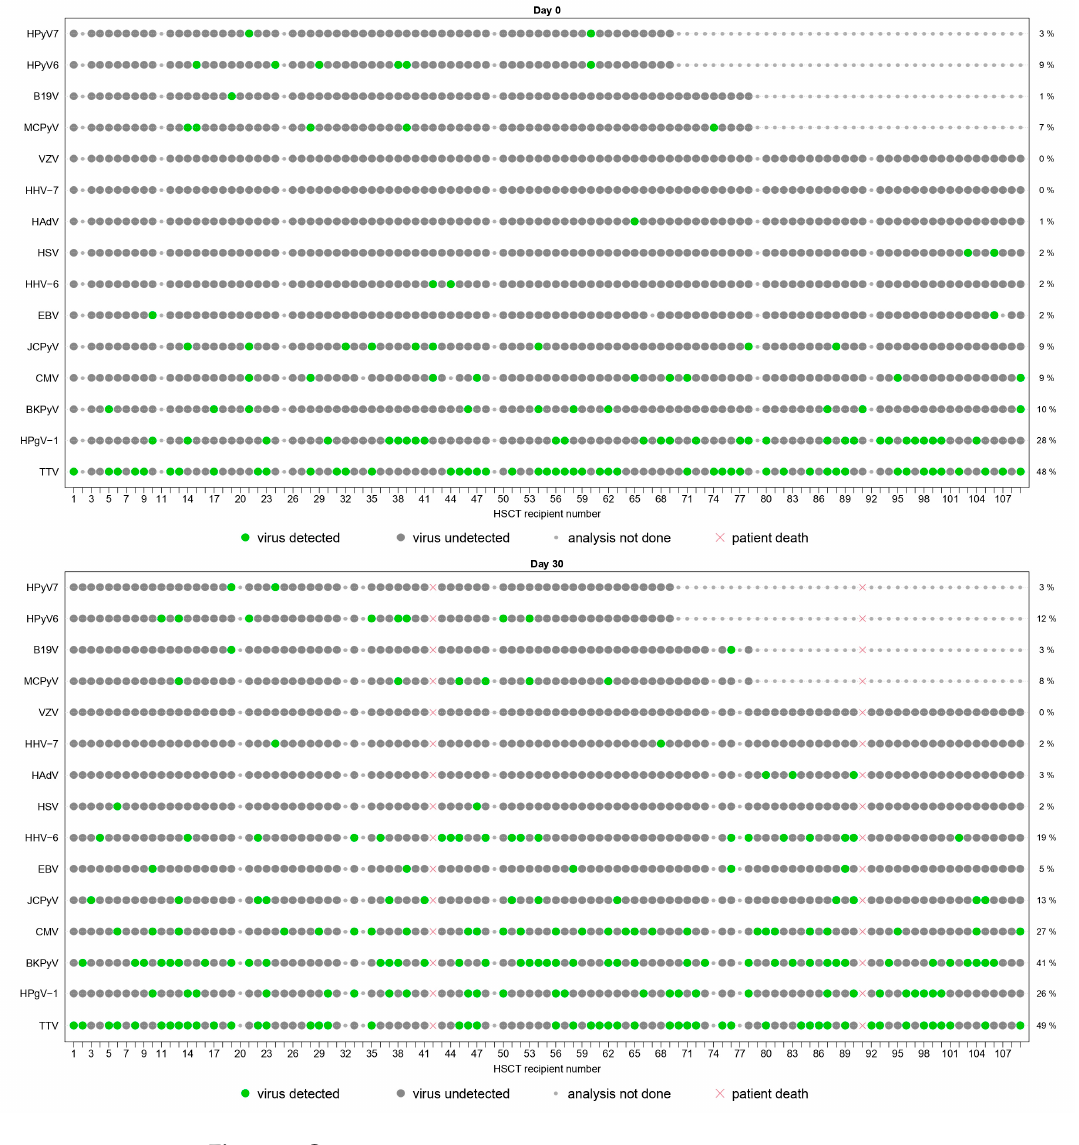
The panels represent the plasma detection of viral species screened on plasma samples at day 0 (D0), day 30 (D30), month 3 (M3), month 6 (M6), year 1 (Y1). Each column represents one patient and the patients’ order stays the same throughout all graphs. Each line corresponds to one viral species. Green dots represent positive results of r(RT-)PCR assays. Grey dots represent negative results of r(RT-)PCR assays. The small grey dots represent analyses that were not performed due to the following reasons: viral species not included in the pre-specified group of testing, insufficient plasma sample volume, plasma sample not collected at the time of visit or missed visit. Red crosses represent analyses that were not performed due to patient’s death. All viral species are represented, except HPyV9, HPg-V2, HBoV, EV and TSPyV, which were never detected at any